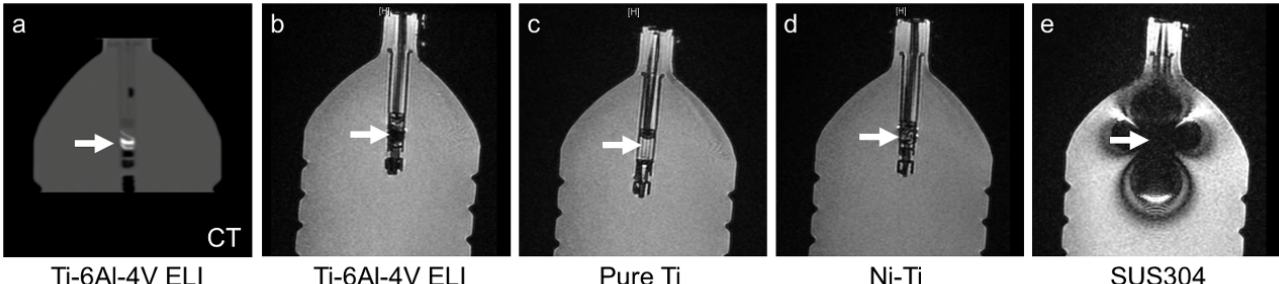
Figure 1. The novel MRI-compatible Ti alloy helical wire-reinforced endotracheal tube (Ti-rET). ( a ) Blueprint of the Ti-rET. a, pitch 1.3 mm; b, wire diameter thickness 0.2 mm; c, wire diameter width 0.5 mm ( b ) An overview of the Ti-rET.